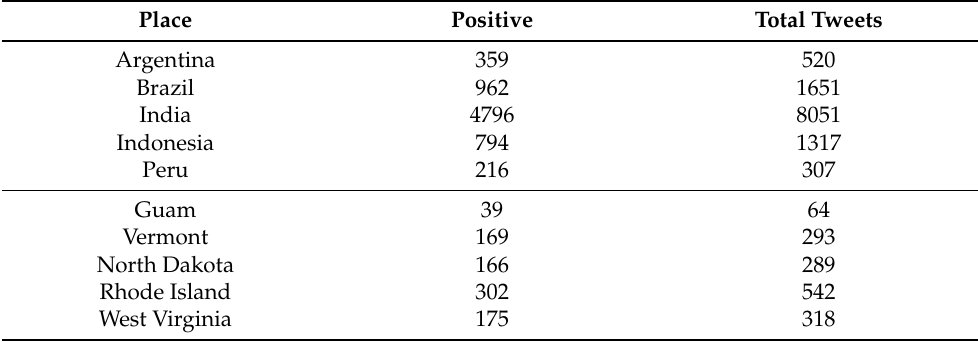
Table 1. Positive tweets, total tweets of countries and states with the least p -value and fraction of positive tweets F >